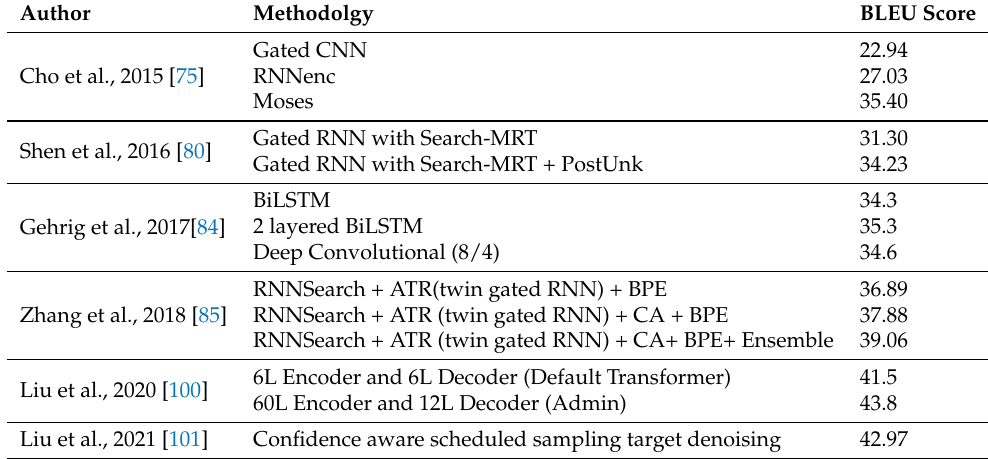
Table 6. Comparison of previously adopted various methodologies scaled on BLEU Score for the translation purpose on English–French language